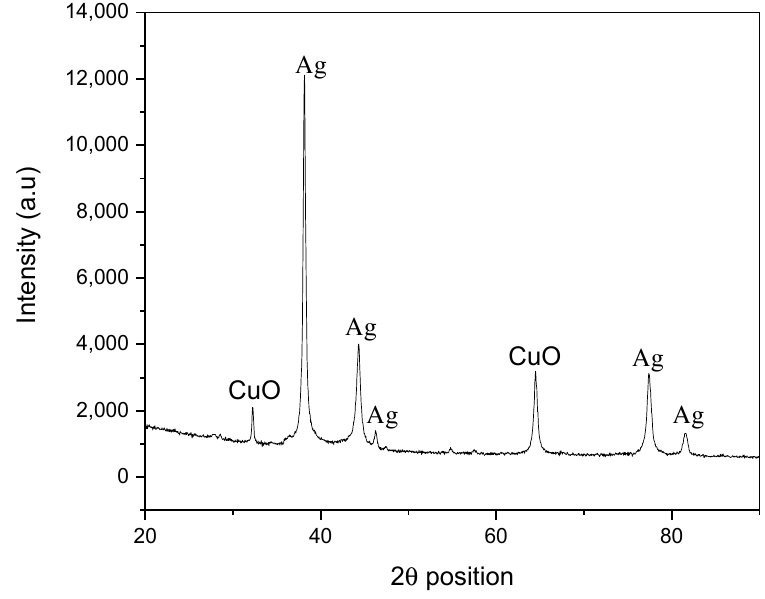
Figure 4. X-ray diffractogram of Ag-CuO NC.